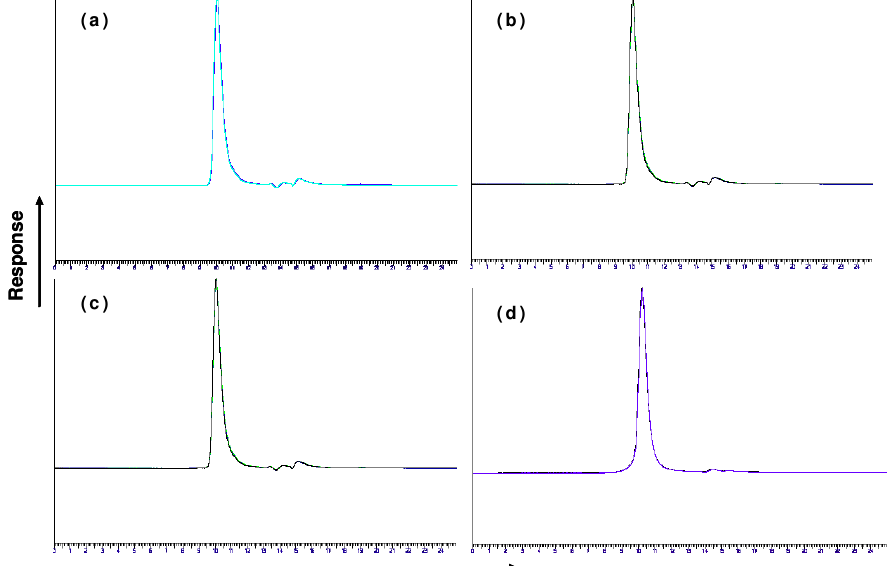
Figure 1. Size exclusion chromatography (SEC) chromatogram of native (control; light blue) trastuzumab overlayed with (a) 0.4 mg/mL trastuzumab sonicated at 1 Watt 1 min (b) 4.0 mg/mL trastuzumab sonicated at 1 Watt 1 min (c) trastuzumab freeze-thawed and (d) tratsuzumab